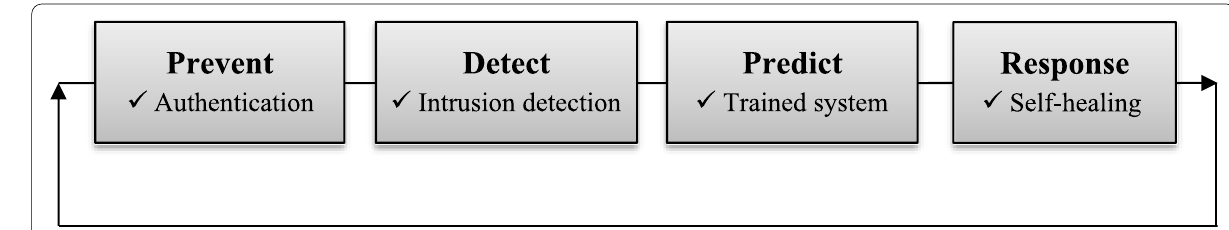
Fig. 6 Aspects of security design for proposed smart